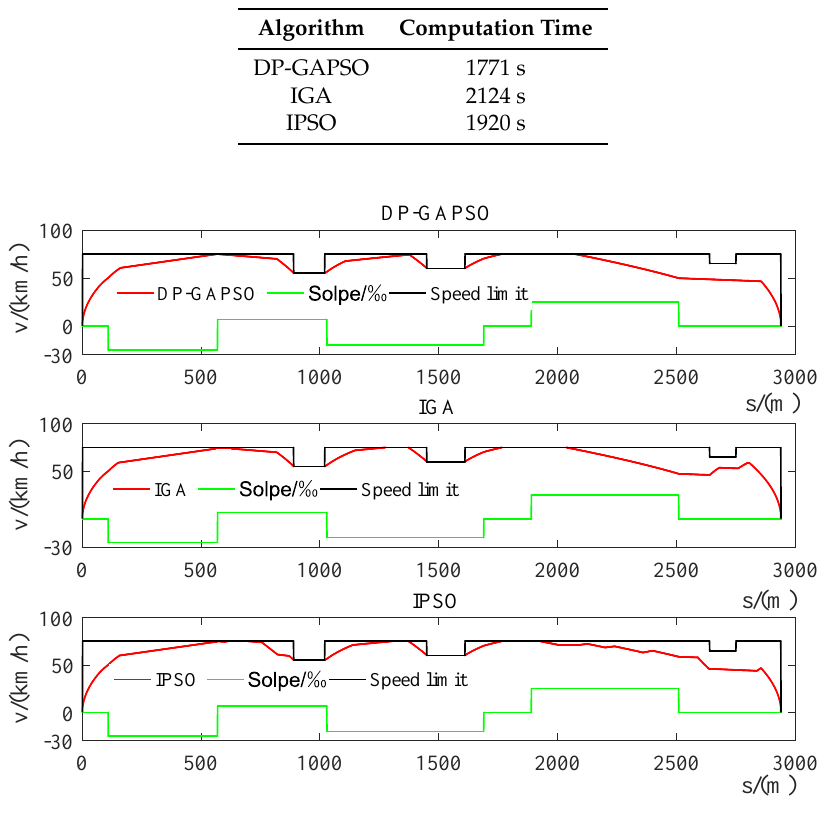
Figure 12. The speed distance curve of the train from New Port in Lvshun to Tieshan town.